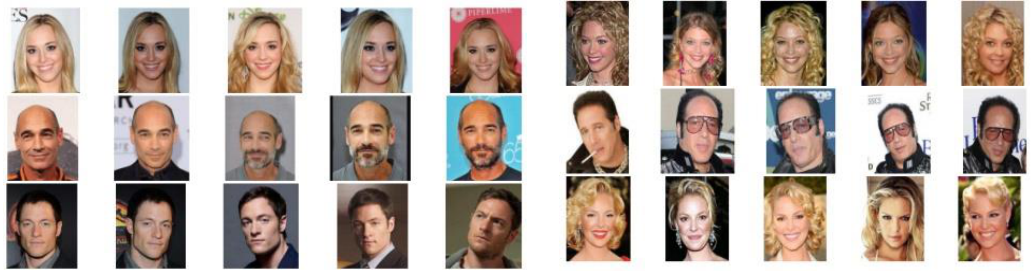
Figure 15. Example images from the VGGFACE (visual geometry group) dataset for six identities.